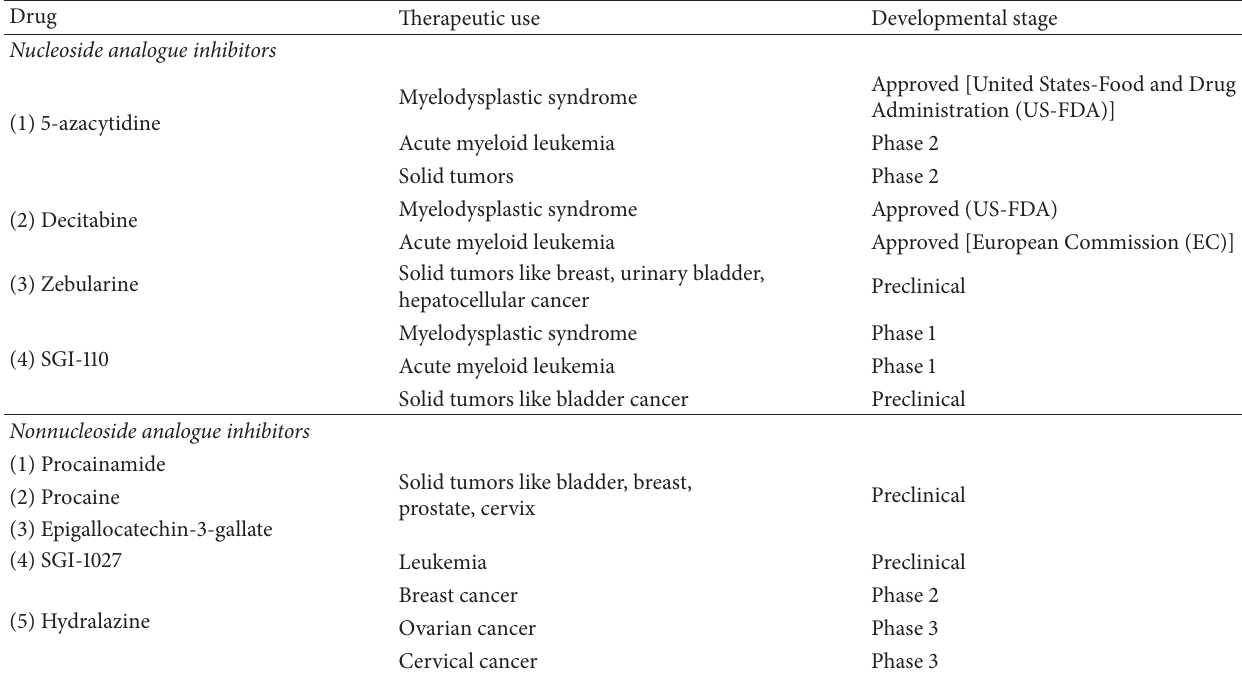
Table 1: DNMT inhibitors in